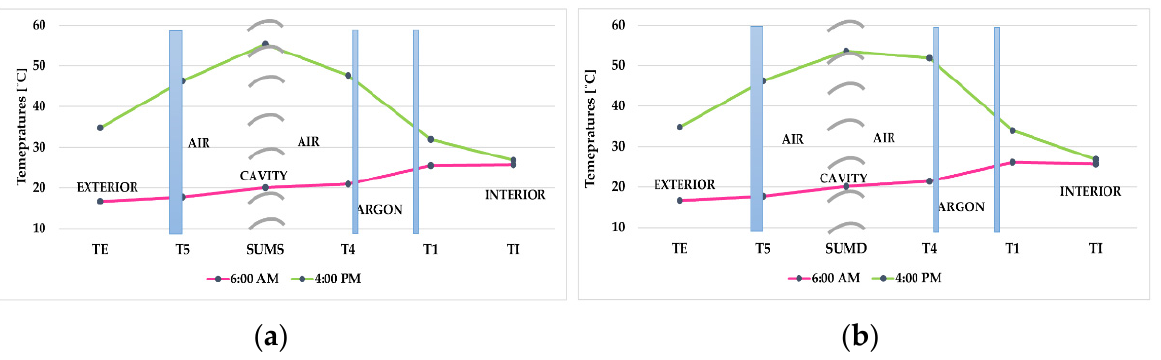
Figure 8. Horizontal temperature variation, when the outside temperature was minimum (6:00 a.m.) and maximum (4:00 p.m.), respectively, for 29 July 2013, for the left line of the translators ( a ) and for the right line of the translators ( b ).